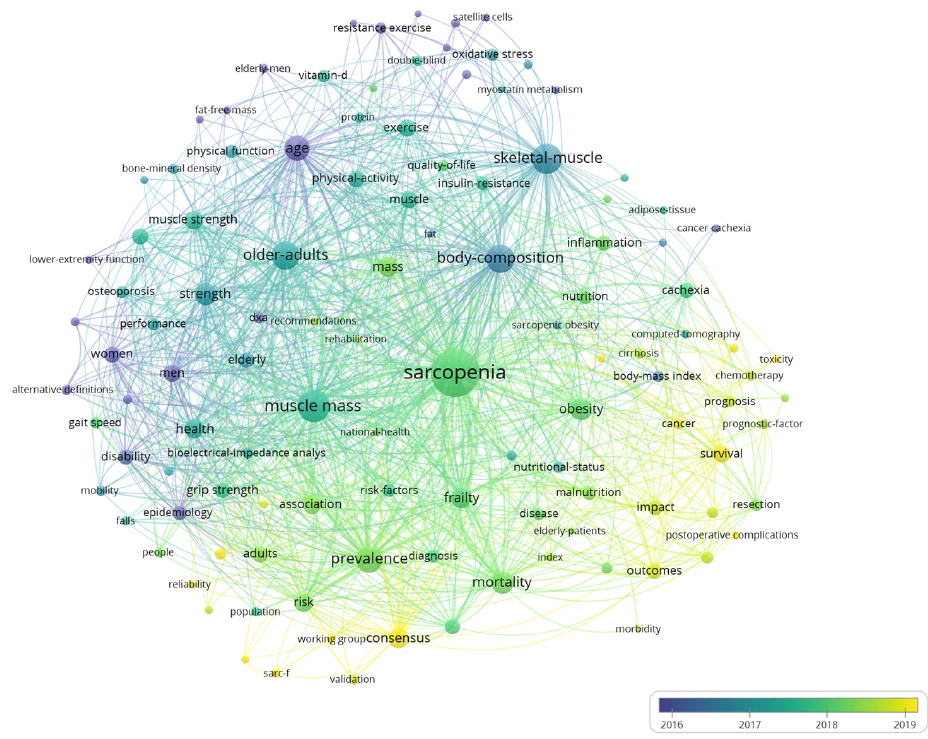
Figure 6. Co-occurrence analysis of 116 keywords with at least 50 times of occurrence.